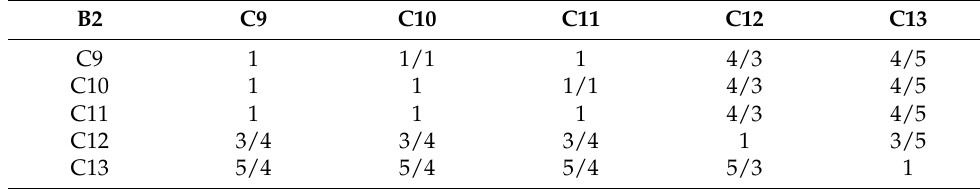
Table A6. B2-C judgment matrix.